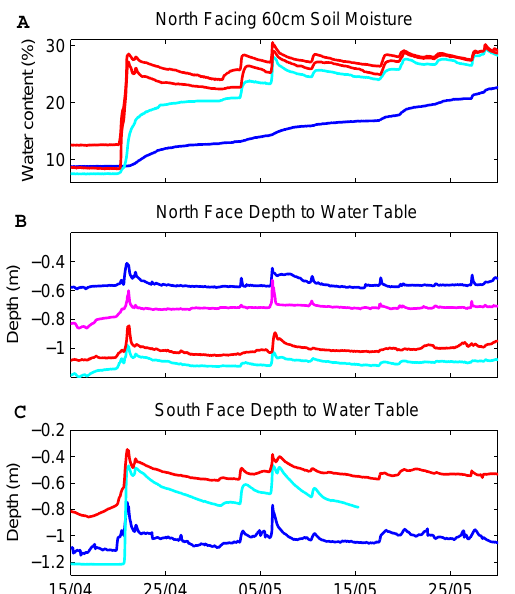
Figure 11. Winter wet-up response of selected soil moisture and water table sensors. (a) Soil moisture on the north-facing slope. Red lines show locations with a fast wet-up; blue lines show locations with a gradual wet-up. (b–C) Depth to water table at north-facing and south-facing slopes. Colours are used only for visual clarity.